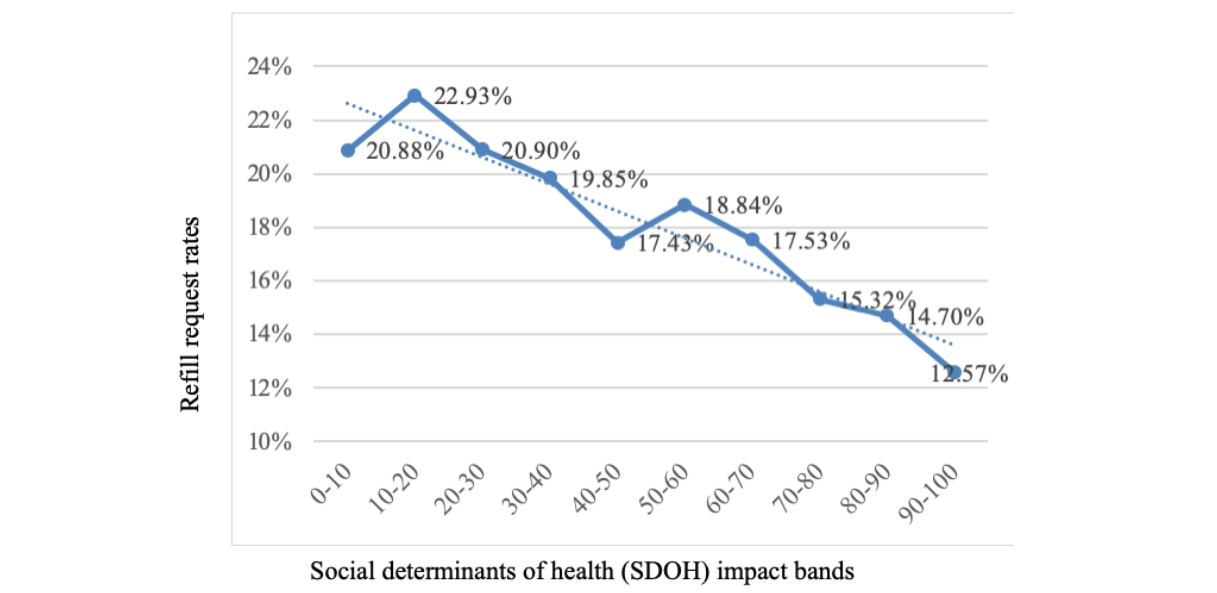
Figure 4. Refill rates versus social determinants of health